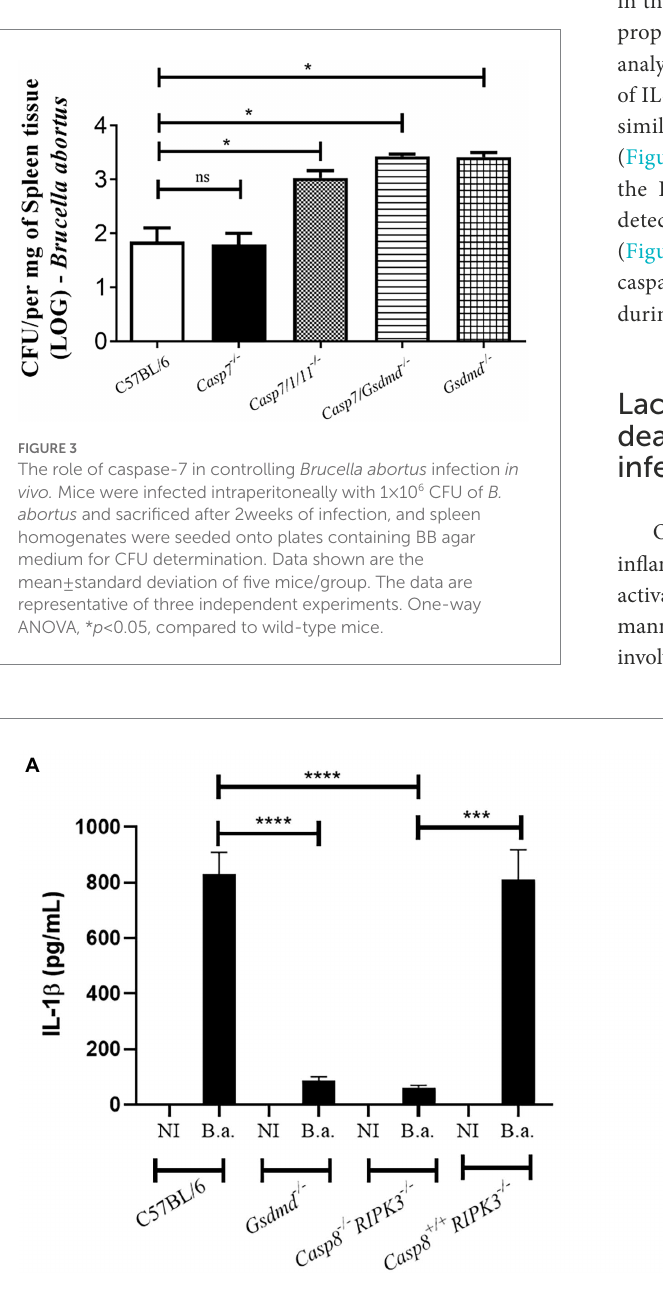
FIGURE 4 Caspase-8 participates in caspase-1 cleavage and IL-1 β secretion in response to B. abortus . BMDMs obtained from C57BL/6, Gsdmd − / − , Casp8/ RIPK3 − / − and Casp8 +/+ /RIPK3 − / − mice were uninfected (NI) or infected with B. abortus S2308 with MOI 100 for 17 h. The supernatant was collected and subjected to ELISA assay to estimate the concentration of IL-1 β (A) . The supernatant was labeled with anti-caspase-1 p20 monoclonal antibody (B) . Data show the mean ± the standard deviation of triplicates. The data are representative of three independent experiments. Student t -test, **** p < 0.0001 compared to C57BL/6 or Casp8 +/+ /RIPK3 − / − . *** p